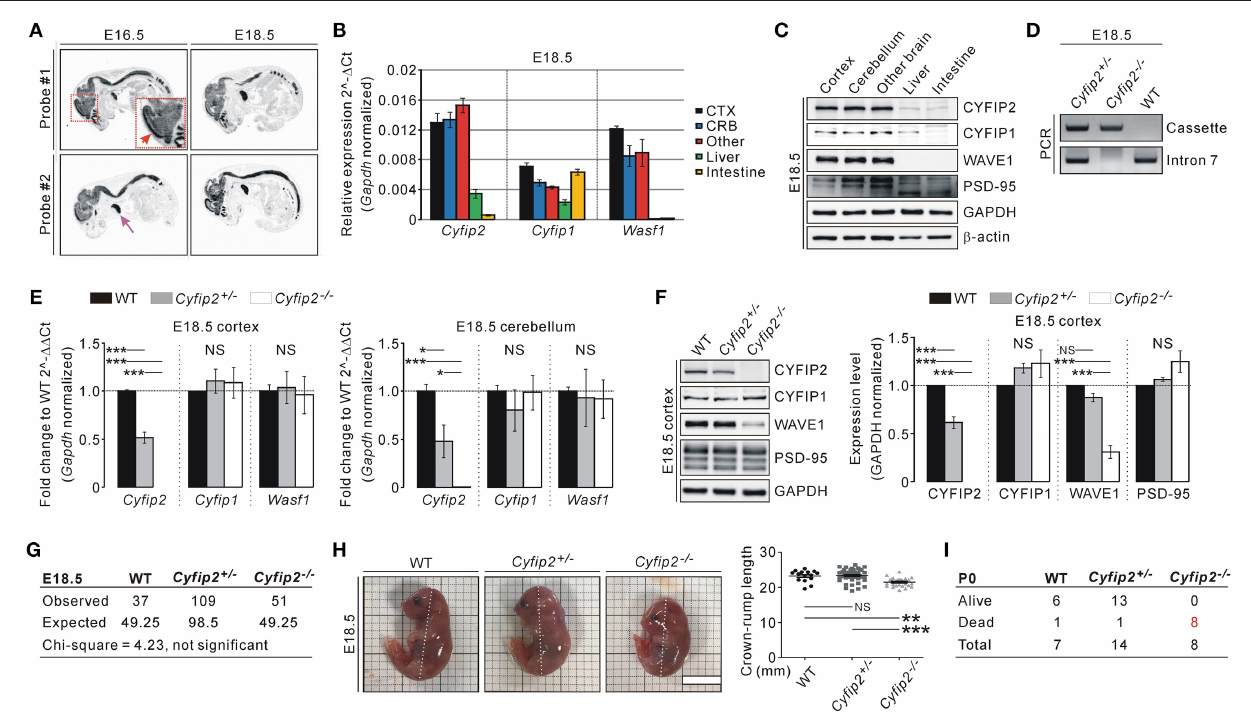
FIGURE 1 | Smaller body size and early postnatal lethality of Cyfip2 − / − embryonic mice. (A) in situ hybridization analysis of Cyfip2 in E16.5 and E18.5 WT mice. The red and purple arrows indicate the cortical region and thymus, respectively. (B) qRT-PCR analysis of Cyfip1 , Cyfip2 , and Wasf1 mRNAs in tissue samples from E18.5 WT mice. CTX, cortex; CRB, cerebellum; Other, other brain regions. (C) Western blot analysis of CYFIP1, CYFIP2, and WAVE1 proteins in tissue samples from E18.5 WT mice. (D) Genotyping PCR results of E18.5 WT, Cyfip2 + / − , and Cyfip2 − / − mice. (E) qRT-PCR analysis of Cyfip1 , Cyfip2 , and Wasf1 mRNAs in the cortex (left panel) and cerebellum (right panel) of E18.5 WT, Cyfip2 + / − , and Cyfip2 − / − mice ( n = 4 mice per genotype). NS, not significant. (F) Western blot analysis of CYFIP1, CYFIP2, and WAVE1 proteins in the cortex of E18.5 WT, Cyfip2 + / − , and Cyfip2 − / − mice ( n = 4). A synaptic protein PSD-95 was blotted as a control. (G) The numbers of observed WT, Cyfip2 + / − , and Cyfip2 − / − mice at E18.5. They are not statistically different from the numbers expected from Mendelian ratios, based on the Chi-square test. (H) Representative images and quantifications show smaller body size (crown-rump length, dotted line) of E18.5 Cyfip2 − / − mice compared with WT and Cyfip2 + / − littermates ( n = 15, 44, 26 for WT, Cyfip2 + / − , and Cyfip2 − / − mice, respectively). Scale bar, 1cm. (I) The numbers of observed alive or dead WT, Cyfip2 + / − , and Cyfip2 − / − mice at